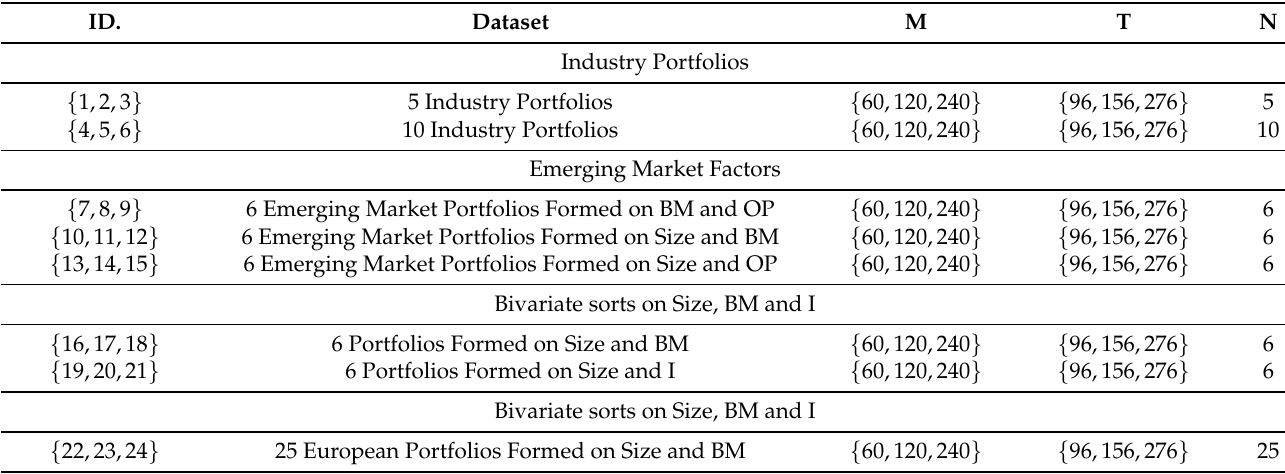
Table 1. Characteristics of the benchmark